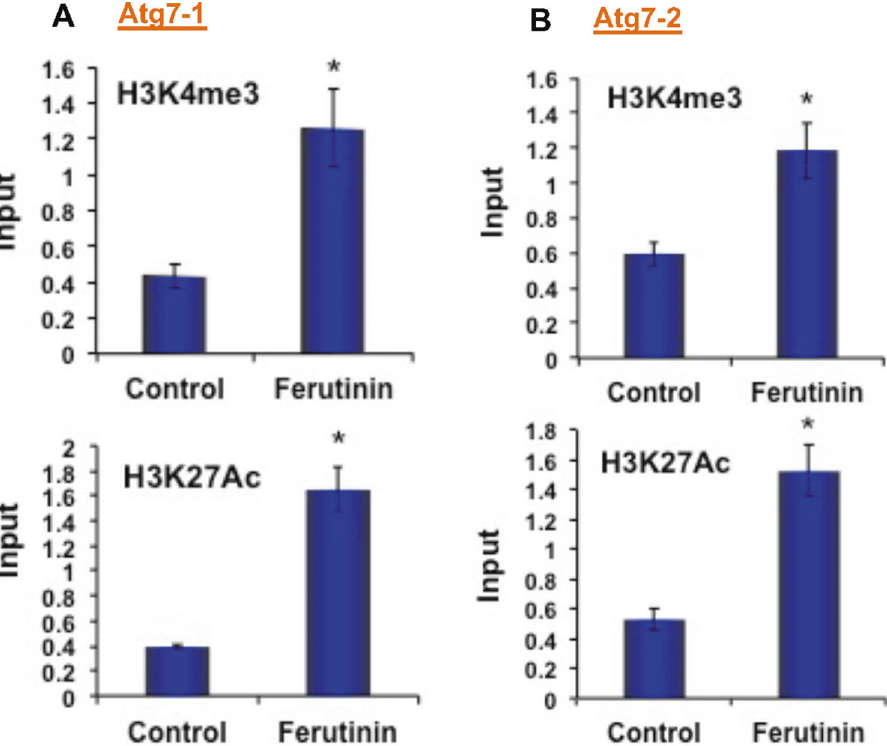
Fig. 8 Ferutinin regulates the ATG7 gene epigenetically in DPSCs. Autophagy signaling pathway molecule ATG7 was analyzed using KLF2- ChIP and quantitative PCR methods after the addition of ferutinin to the DPSCs for 24 h. Active marks of the ATG7 gene for both H3K4me3 and H3K27Ac molecules were evaluated in the promoter site using two different primers such as A ATG7-1 and B ATG7-2, and shown graphically. Vehicle-treated DPSCs were considered as a control. Star (*) indicates a statistical signi fi cance ( p < 0.05) when compared ferutinin-treated cells to the controls ( n =